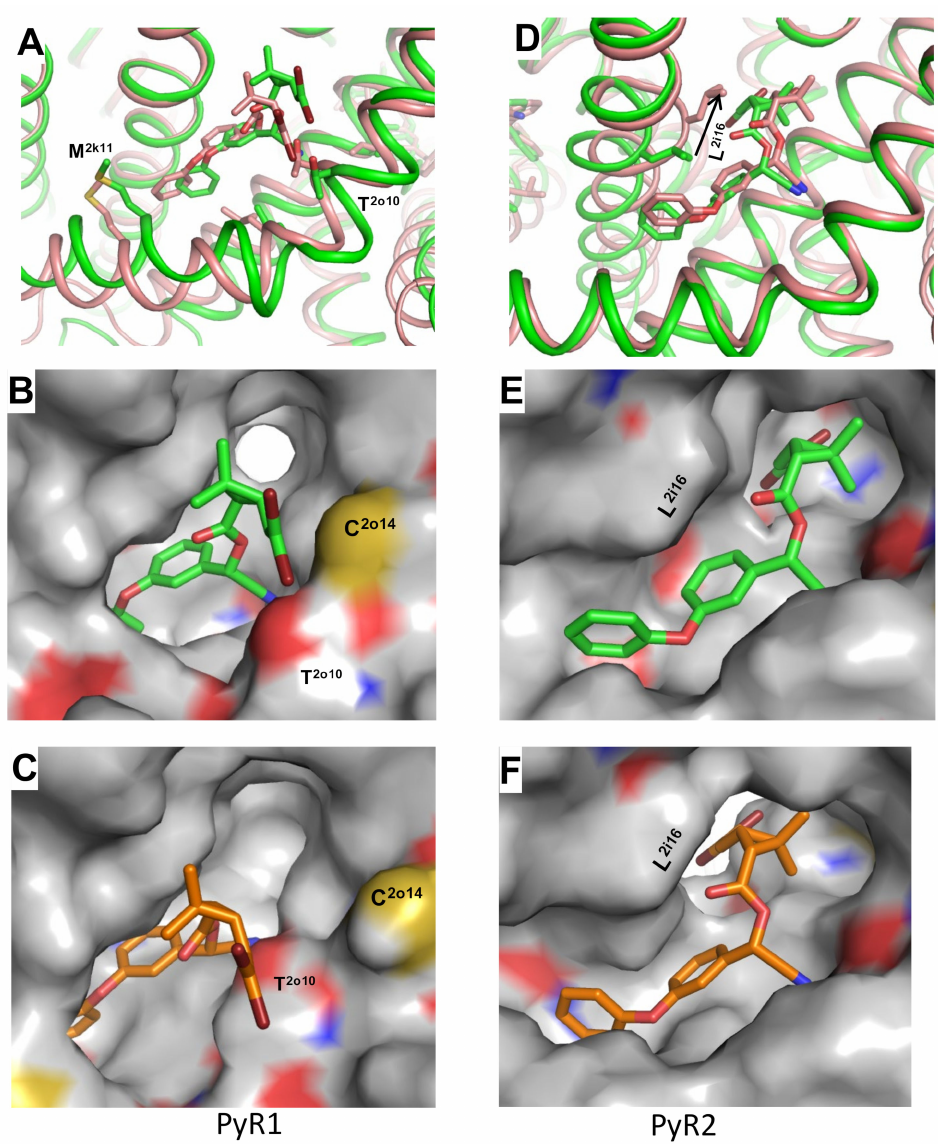
Figure 3. In silico inactivating DMT-bound model o AaNav1-1. ( A ) Superposition of models o AaNav1- 1 (green) and o-i AaNav1-1 (pink) with DMT in PyR1. ( B , C ) Surface representation of models o AaNav1- 1 ( B ) and o-i AaNav1-1 ( C ) with DMT in site PyR1. Note a significant shift of the CBr 2 group that lost halogen bonds with T 2o10 and C 2o14 . ( D ) Superposition of models o AaNav1-1 and o-i AaNav1-1 with DMT in site PyR2. ( E , F ) Surface representation of models o AaNav1-1. ( E ) and o-i AaNav1-1 ( F ) with DMT in PyR2. Note a significant shift of L 2i16 that lost favorable contacts with the DMT aromatic